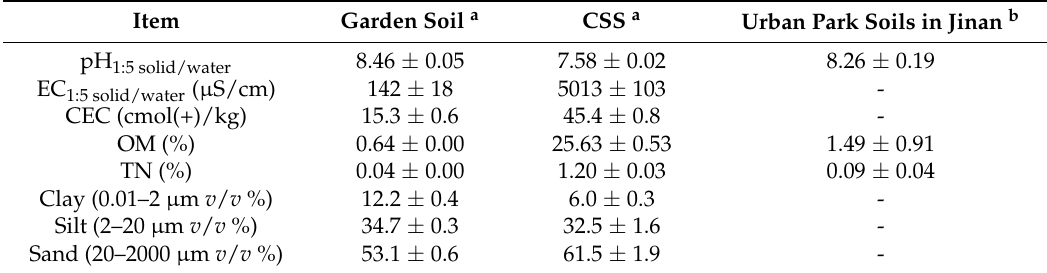
Table 1. Physicochemical properties of the garden soil and composted sewage sludge (CSS) in the present study and of urban park soils in Jinan, Shandong Province. EC: electrical conductivity; CEC: cation exchange capacity; OM: organic matter; TN: total